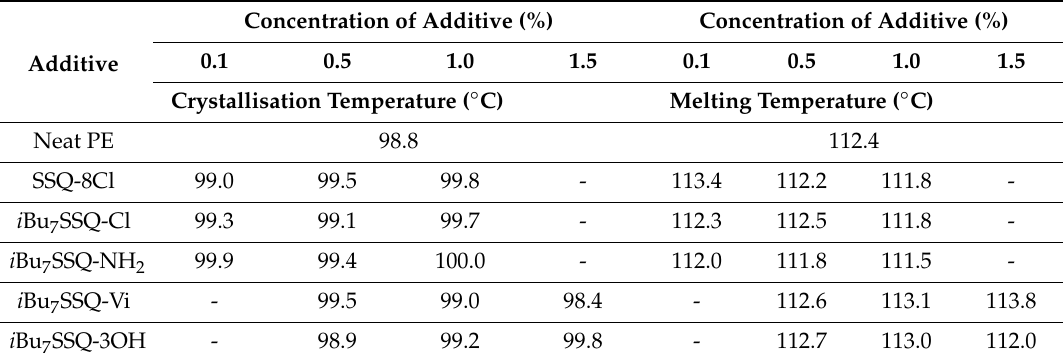
Table 5. Melting and crystallisation temperatures of obtained